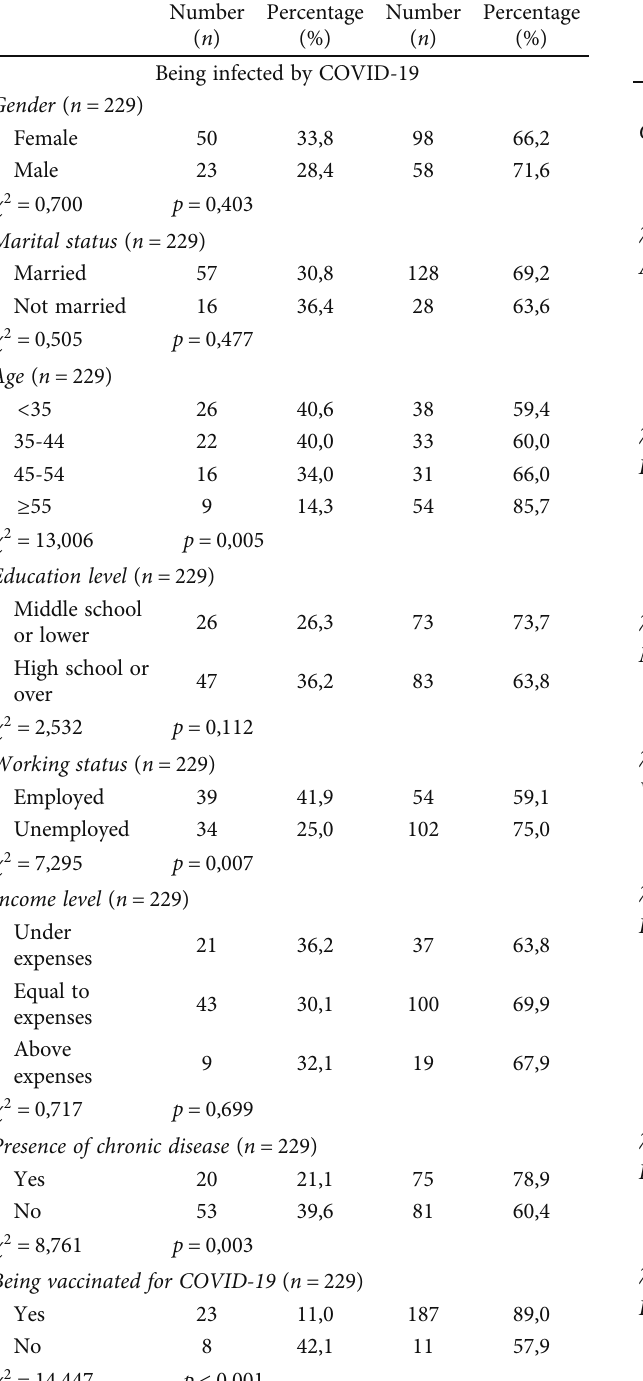
Table 3: Status of having COVID-19 infection according to some features of the participants, Kastamonu, 2022.